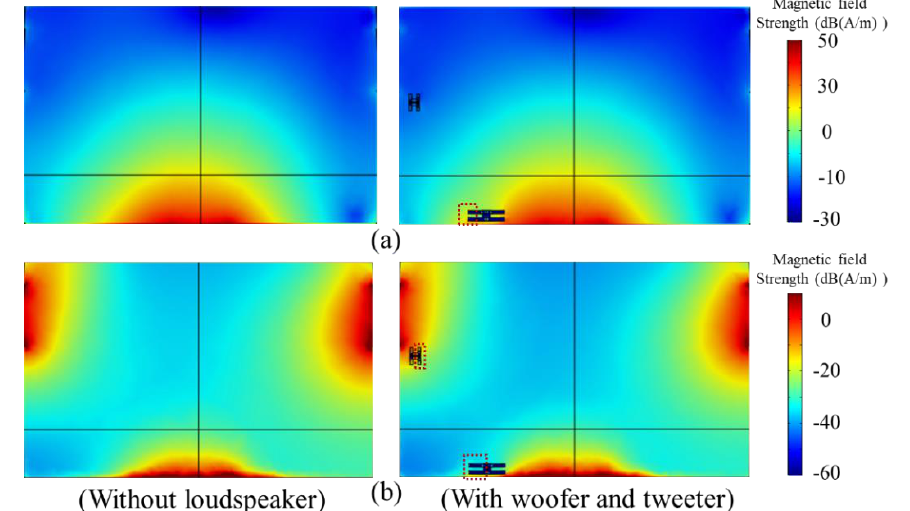
Figure 5. Comparison of magnetic field strength in the vehicle with and without the glass window in the vehicle gate with different vehicle body materials ( a ) CFRP, ( b ) Aluminum.